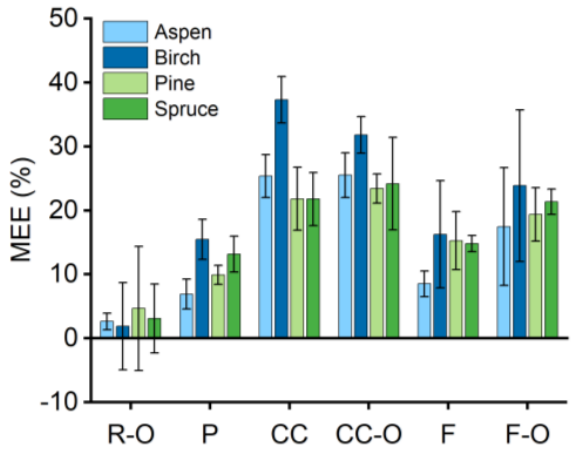
Figure 3. Moisture exclusion efficiency (MEE) calculated from mass gain at adsorption between 30 and 95% RH, in relation to unmodified reference of respected species. Error bars for SD.